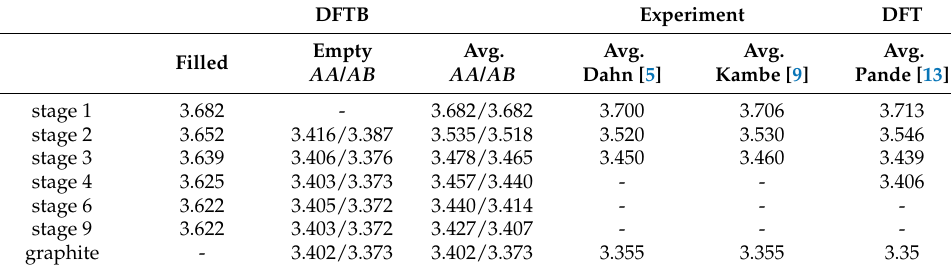
Figure 2. ( Left ): Average C–C interlayer distance in the z direction as a function of the stage of the compound in Å. AA and AB signifies AA -stacking and AB -stacking assumed for the empty graphite layers. Where available, experimental and theoretical references are also shown. The curves ‘fit AA’ and ‘fit AB’ correspond to a simple building block model with just two fixed interlayer distances for empty and filled galleries, respectively. For stages 3 and higher, our predictions adhere closely to that model. For stages 1 and 2, the interlayer spacing of the filled galleries was expanded due to the additional charge transfer. ( Right ): Interlayer spacing of the full galleries, as well as empty galleries in AA and AB stacking, as a function of the stage (calculated with GPrep-DFTB). Table 2. C–C interlayer distances in Å. For details, see the caption of Figure